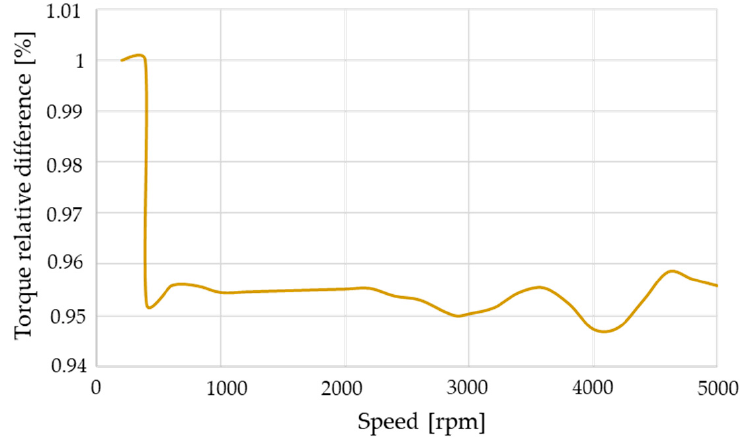
Figure 18. Simulated torque relative difference between hybrid turbo engine and naturally aspired engine at 100% load.